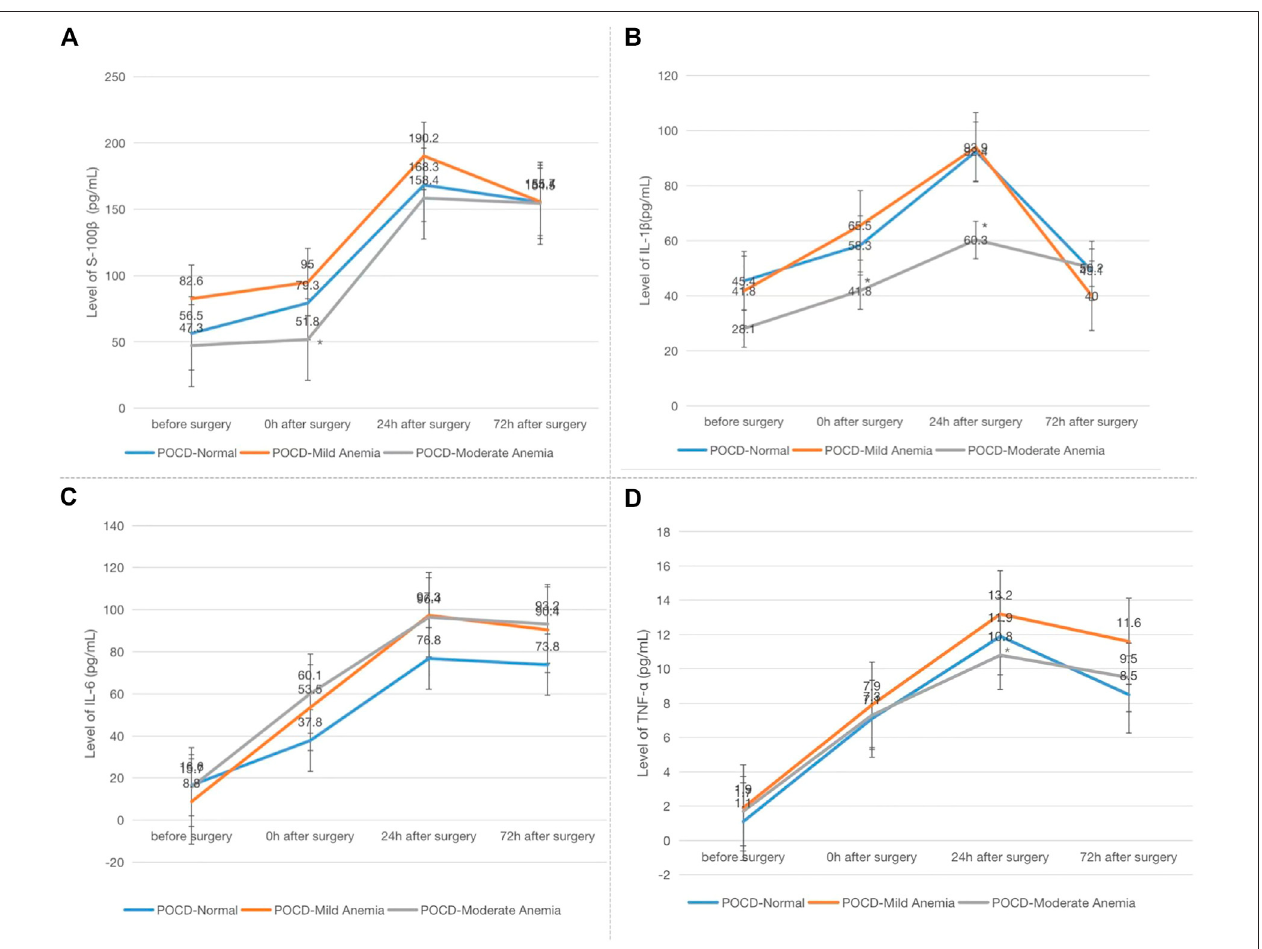
FIGURE 5 | Comparison of serum concentrations of S-100 β , IL-1 β , IL-6 and TNF- α (pg/ml) among patients with POCD who had no anemia, mild anemia or moderate anemia at four time points. Note: (A) S-100 β ; (B) IL-1 β ; (C) IL-6; (D) TNF- α .Comparedwith patients had no anemia or mildanemiainPOCD group, * p < 0.05.